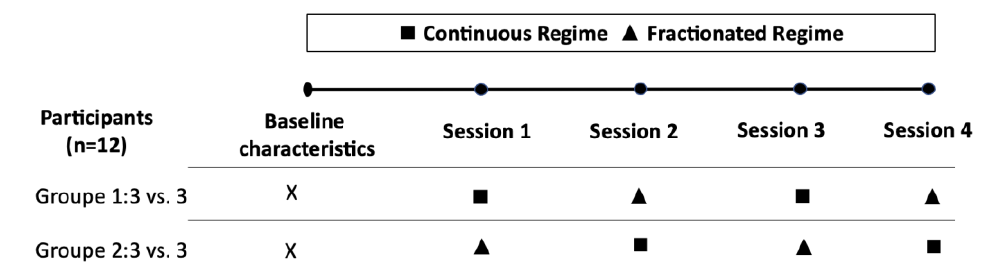
Figure 1. Experimental design.